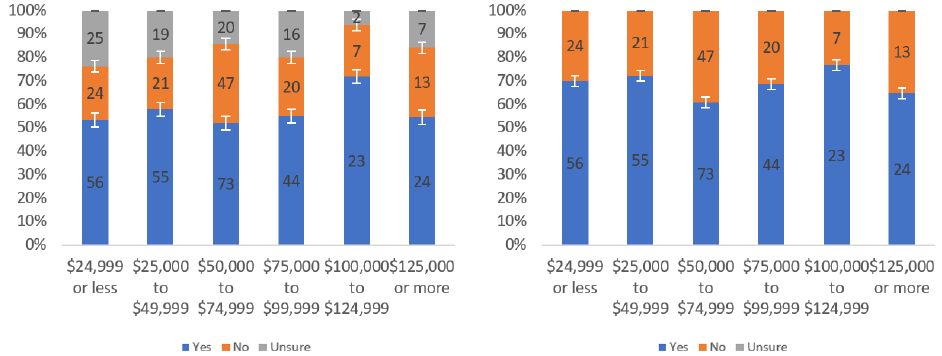
Figure A43. Responses regarding usefulness in judging trustworthiness by income level including ( left ) and excluding ( right ) unsure responses.